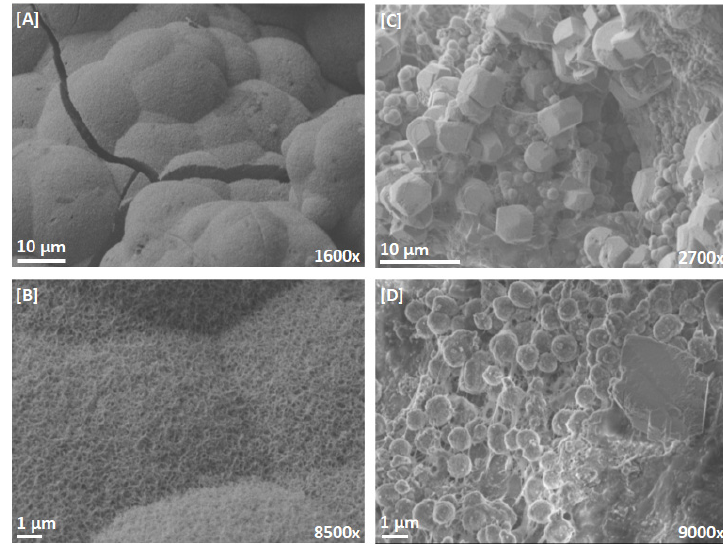
Figure 5. Crystal organization in steel slag filters fed with inorganic (panels ( A ) and ( B )) and organic (panels ( C ) and ( D )) soluble influents. Panels ( A ) and ( B ): Column 1 cell 2. Panel C : Column 2 cell 9. Panel ( D ): Column 2 cell 6.